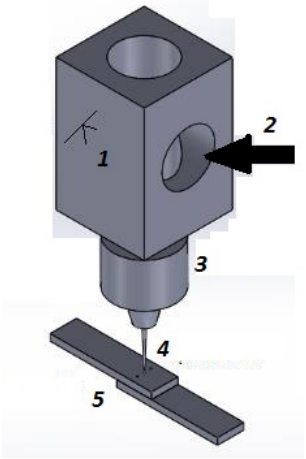
Figure 1: Diagram of the test station, where: 1 – laser head, 2 – laser beam, 3 – focusing lens set, 4 – focused laser radiation, 5 – welded